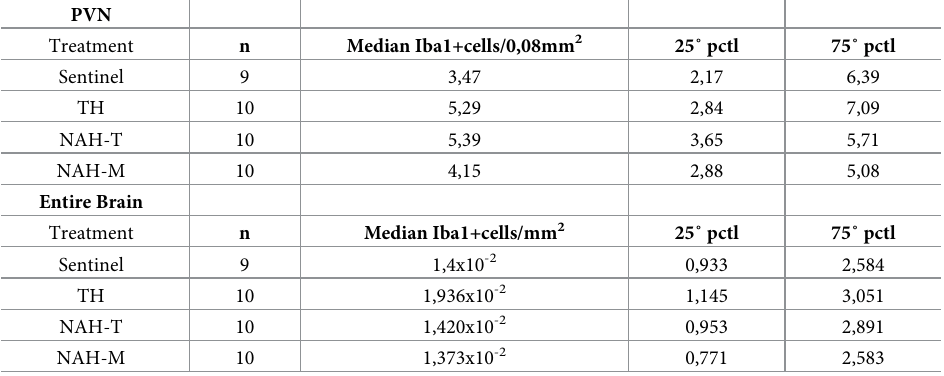
Table 1. Immunohistochemistry staining. Median values of Iba1+ cells number, with interquartile ranges (25˚ ptcl- 75˚ ptcl), present in the PVN (H of KW = 2.51, p-value KW = 0.473, Eta 2 0%) and in the entire brain slice (H of KW = 1.69, p-value KW = 0.638, Eta 2 = 0%) after immunohistochemistry